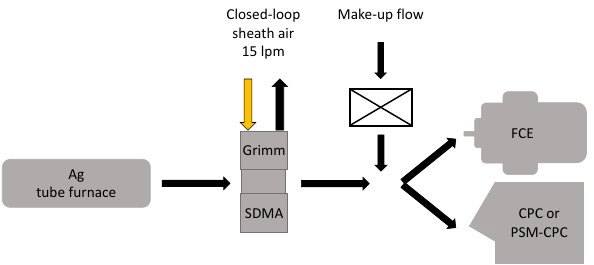
Figure 6. Calibration setup for the determination of the counting efficiency curve of the three types of condensation particle counters used. Silver aerosol particles are generated in a tube furnace and classified in one of the Grimm S-DMAs. Afterwards the flow is split into the CPC under investigation and a reference FCE.